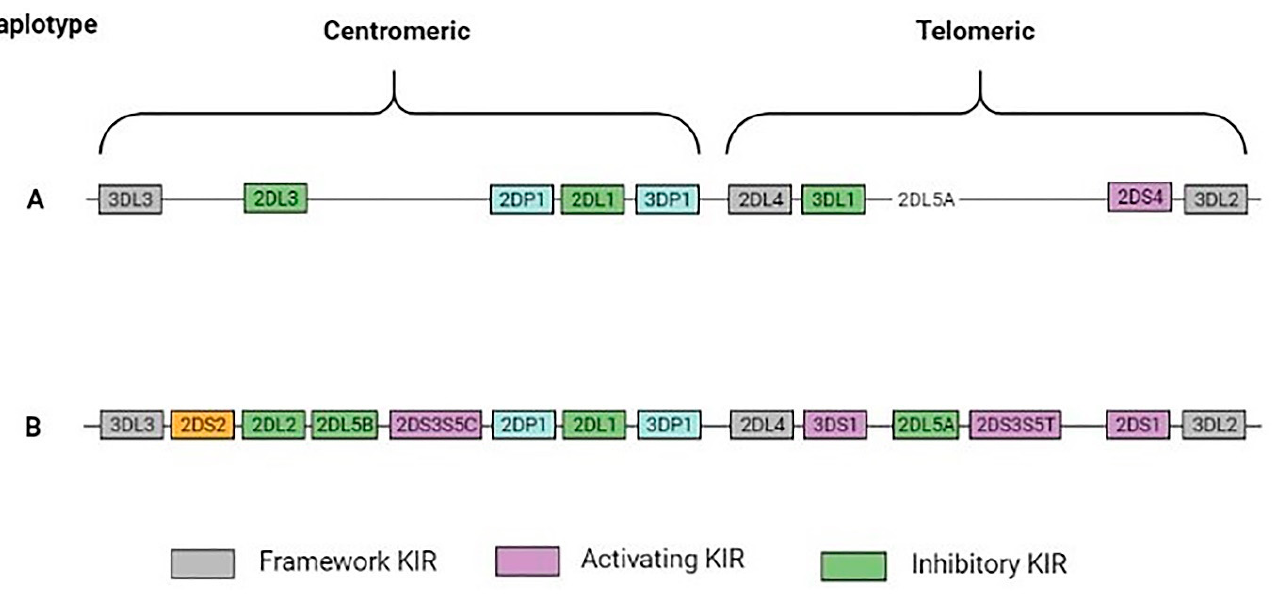
Figure 4. Genomic organization of KIR A haplotype and B representative haplotype. Activating KIRs are indicated in violet, inhibitory KIRs in green, framework KIRs in grey, and pseudogenes in